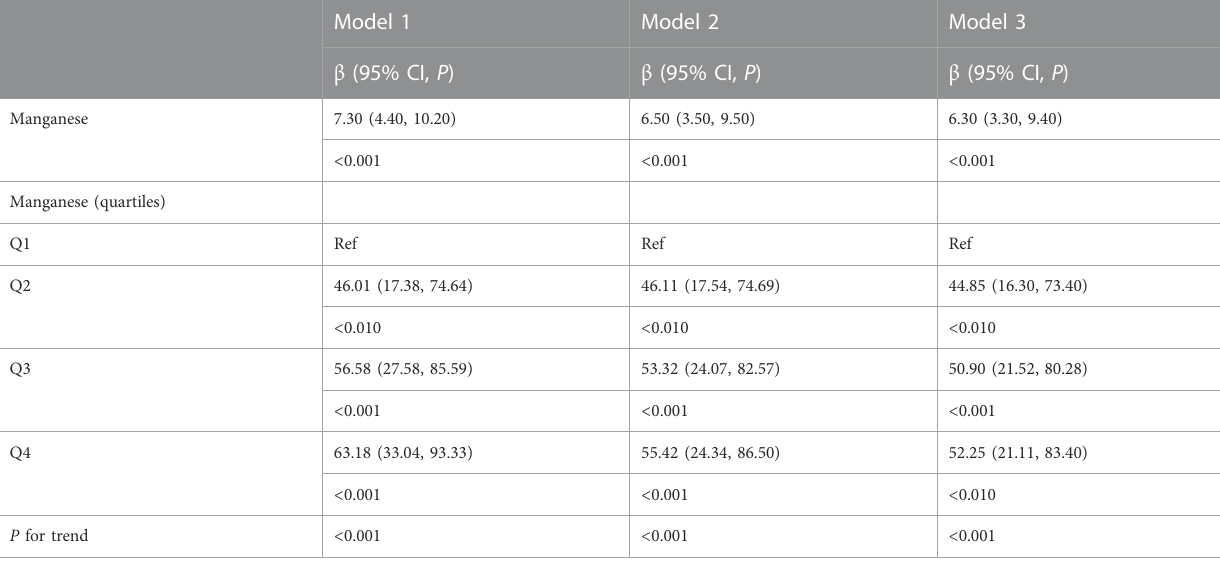
TABLE 2 Associations between the serum manganese ( μ g/L) and serum klotho (pg/mL) levels.